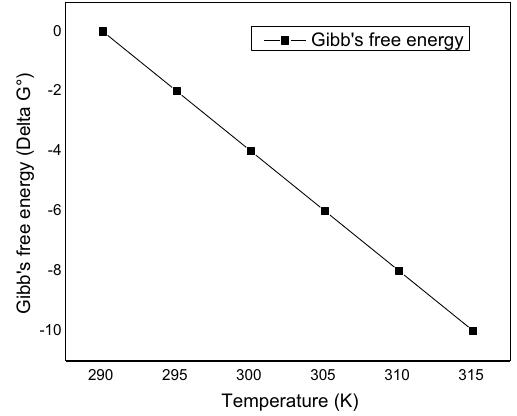
Fig. 18 ∆G° (change in Gibb’s free energy) versus T (temperature) for MR sorption onto